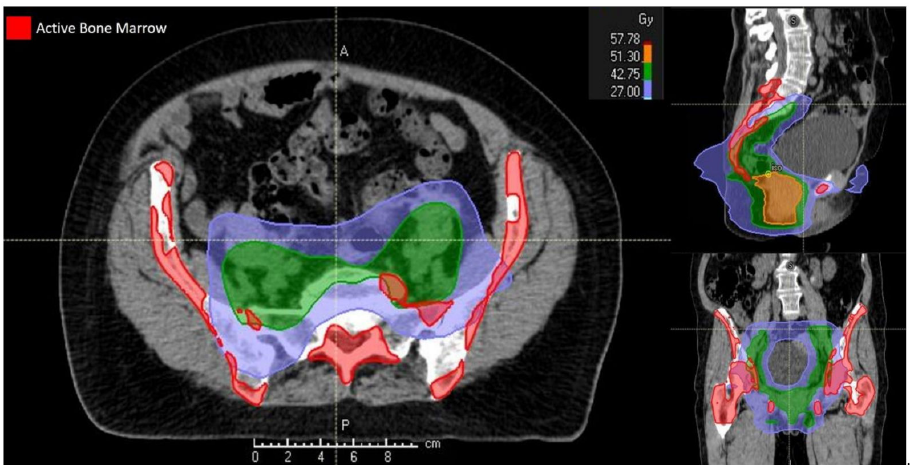
Figure 2. Isodose distribution for a bone marrow-sparing intensity-modulated radiotherapy treatment